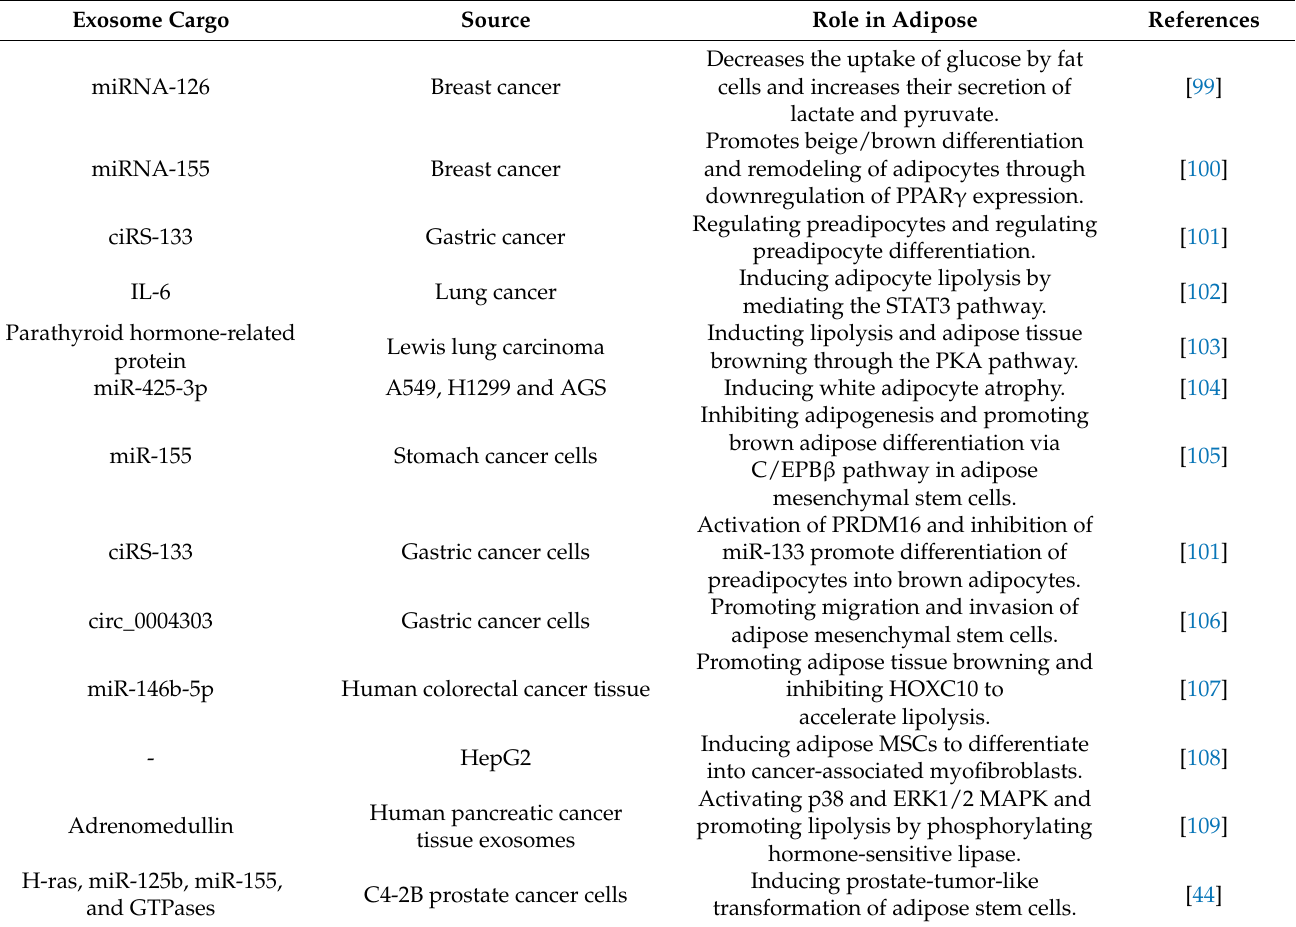
Table 3. Effects of tumor-derived exosomes on